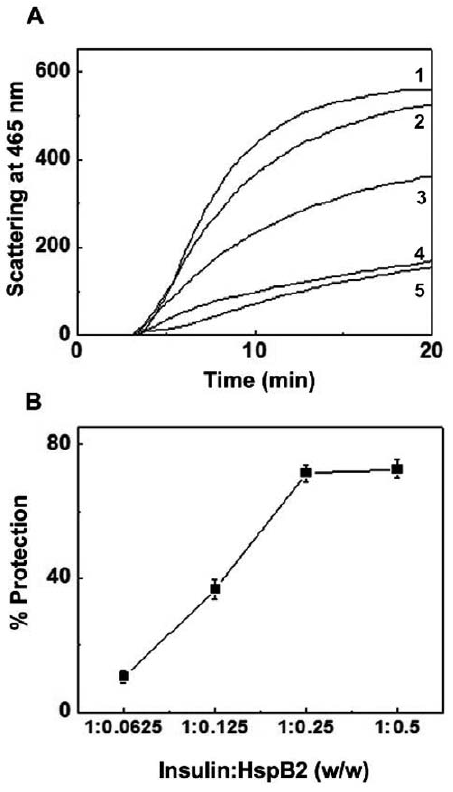
Figure 7. Chaperone-like activity of human HspB2 towards DTT-induced aggregation of insulin. (a) Aggregation profile of 0.2 mg/ml insulin alone (1); and in the presence of 1:0.0625, (2); 1:0.125, (3); 1:0.25, (4); and 1:0.5, (5) ratios of insulin to HspB2 (w/w). (b) The percentage protection of DTT-induced aggregation of insulin by HspB2 as a function of weight ratio of chaperone to target